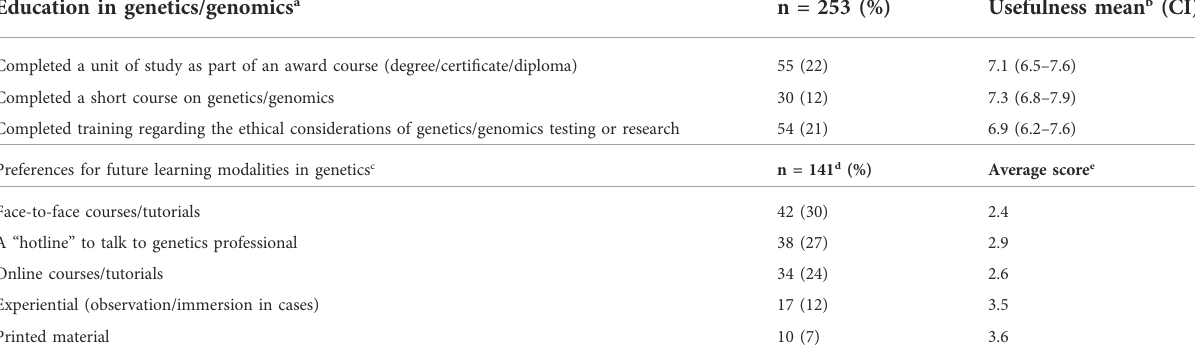
TABLE 4 Prior experience with genetic/genomic education and training, and preferences for future learning.